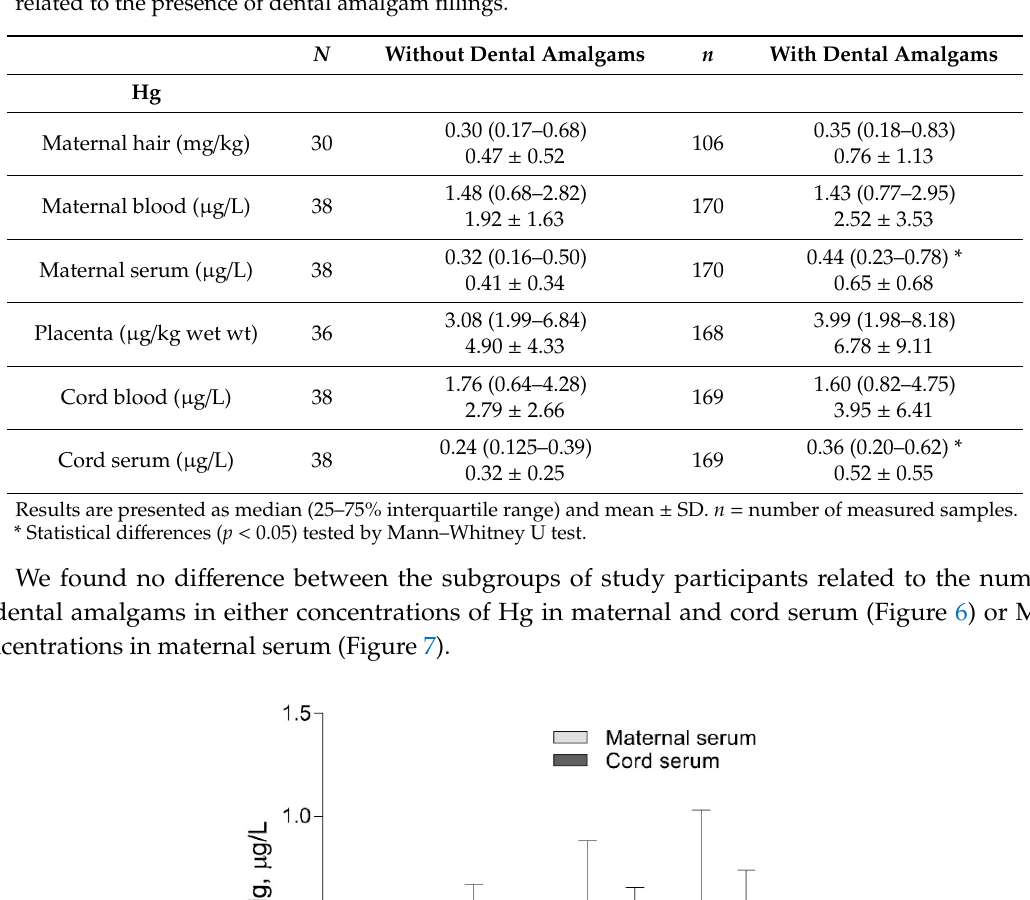
Table 3. Concentrations of total mercury (Hg) in maternal hair and serum, placenta and cord serum related to the presence of dental amalgam fillings.